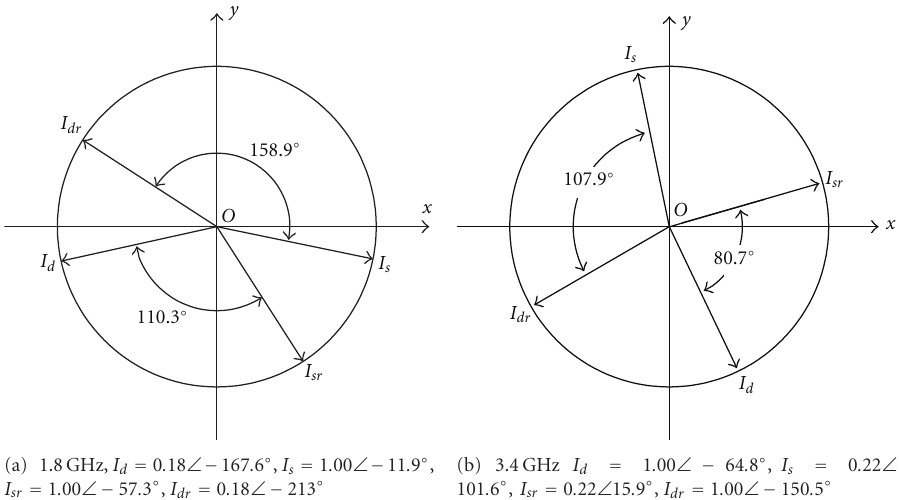
Figure 5: Equivalent radiation current vector diagram of the